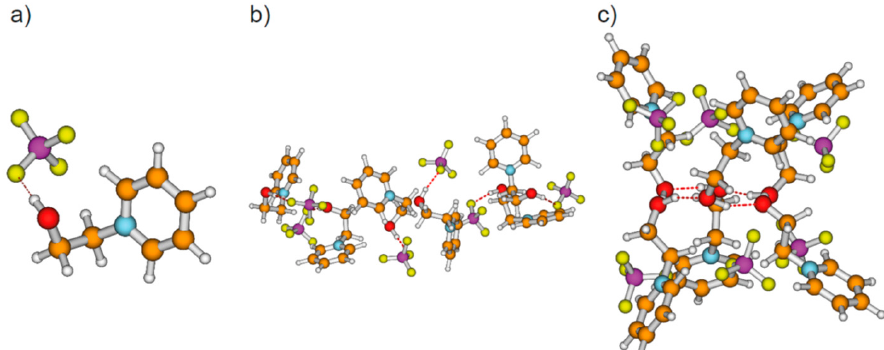
Figure 2. Topologies of calculated cationic clusters [HO-(CH 2 ) 4 -Py + ] n with n = 1–6 comprising ( a ) monomers, ( b ) linear dimers, ( c ) cyclic trimers, ( d ) cyclic tetramers, ( e ) cyclic pentamers, and ( f ) cyclic hexamers as obtained from density functional theory (DFT) calculations at the B3LYP-D3/6–31+G* level of theory.